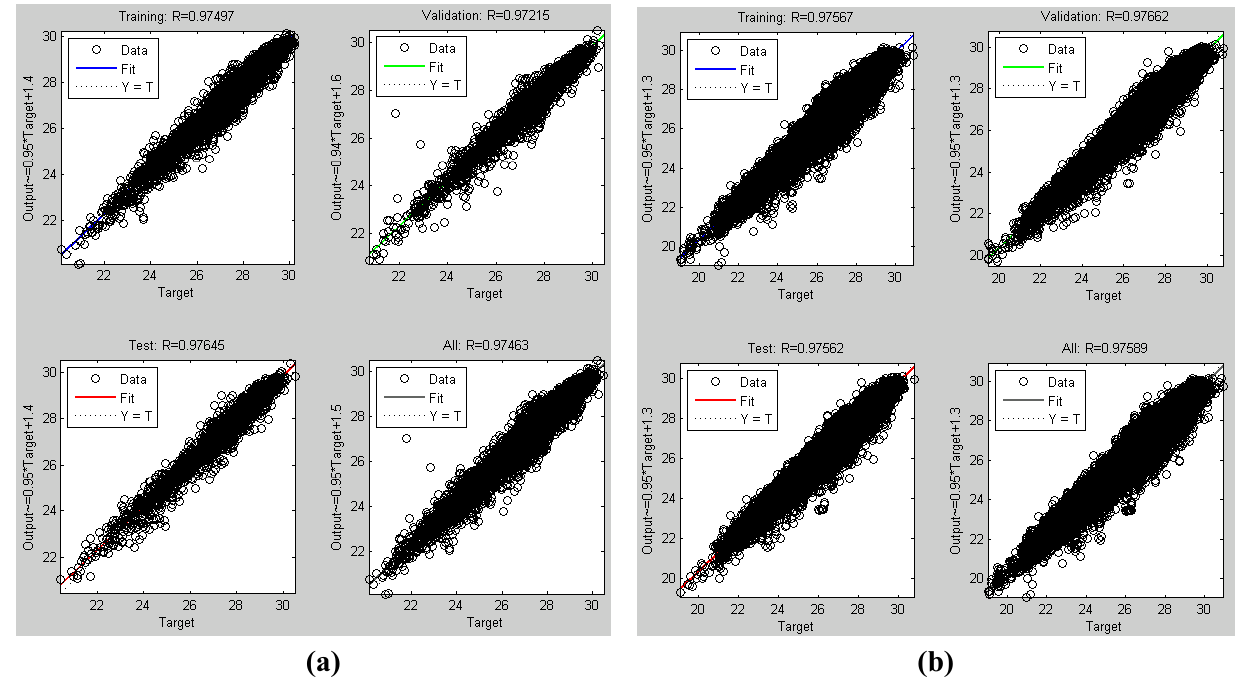
Figure 3. BPN training result by daily mean data (a, c) , and by hourly mean data (b, d)